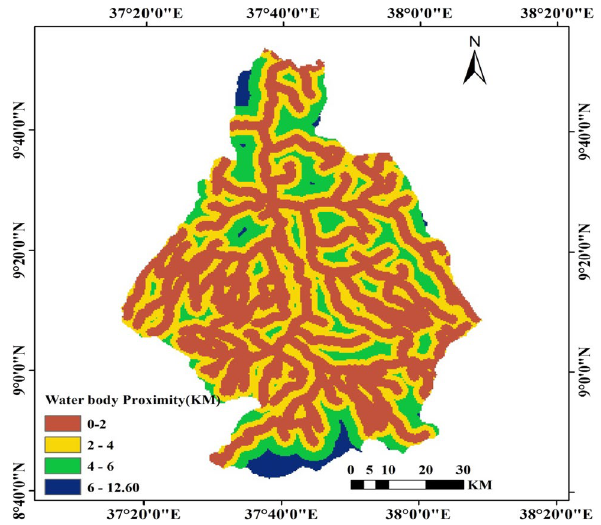
Fig. 7 Water body proximity (KM) map of Guder